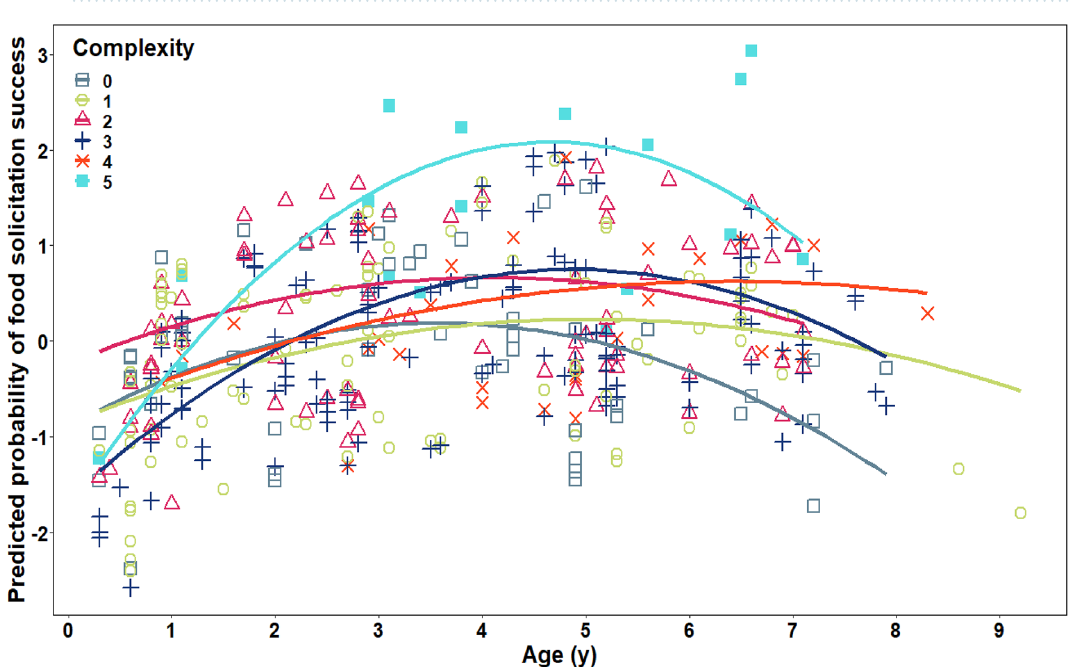
Figure 3. Effects of the age of the offspring and the complexity of the solicited food item on predicted food solicitation success. Complexity was assessed via the number of manual and oral steps it took to process a food item before ingestion and ranged from 0 to 5. The curves show the fitted probability at the 95% level (model 3 , dataset 3 , N = 918 food solicitation